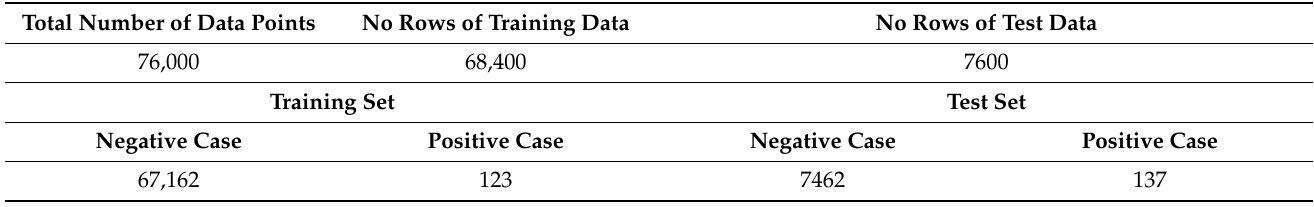
Table 2. Details of the data set and further details of the data